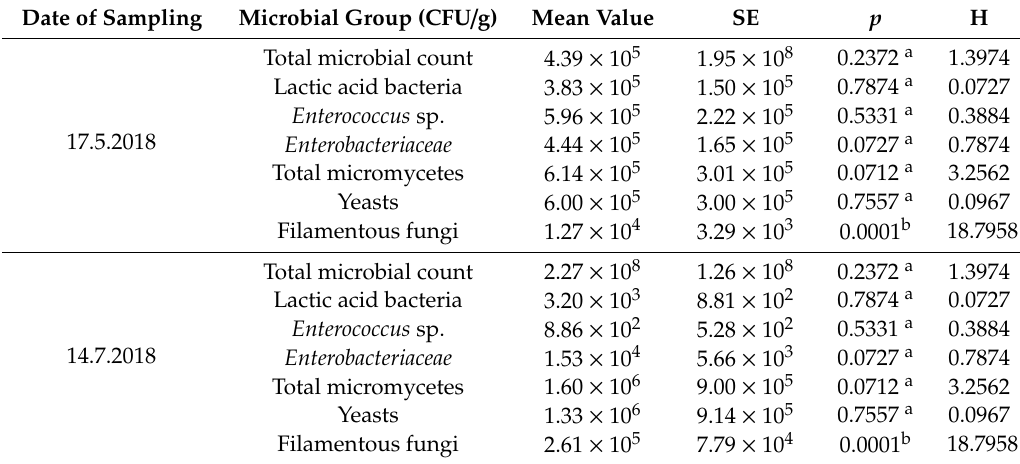
Table 2. Date of sampling e ff ects on microbial counts in plant